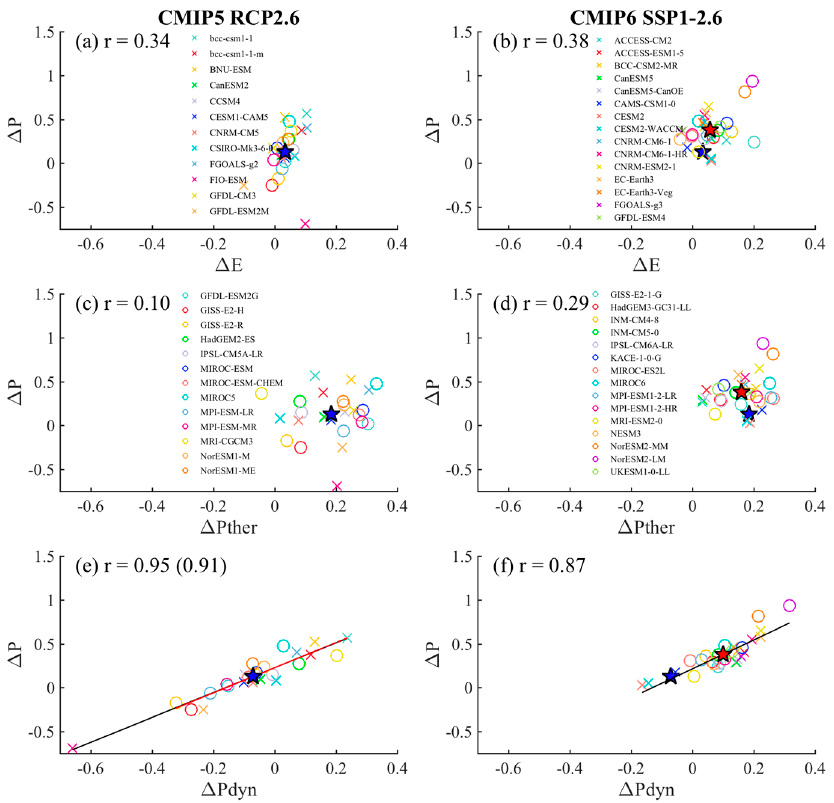
Figure 9. Scatterplot of intermodel relationship between ISM precipitation change and ( a–b ) evap- oration change ( ∆ E , mm day − 1 ), ( c–d ) thermodynamical component ( ∆ P ther , mm day − 1 ) and ( e–f ) dynamical component ( ∆ P dyn , mm day − 1 ). The blue and red stars, respectively, indicate the CMIP5 and CMIP6 MME results. The least squares fitting lines are shown on panels where the intermodel correlation is significant at 95% confidence level. The red fitting line and correlation coefficient in the bracket in Figure 9e are based on the analyses excluding the outlier at the bottom-left corner.